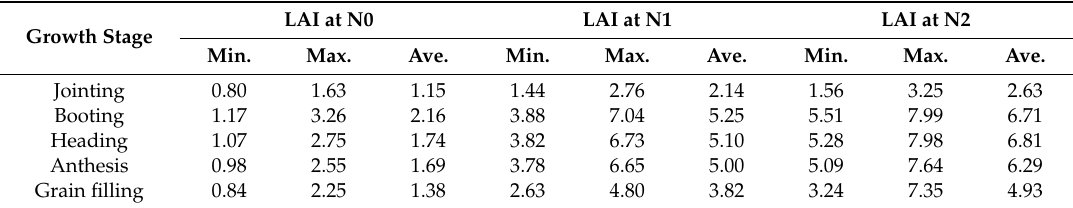
Table 4. The variation of LAI at different growth stages under varied nitrogen rates.